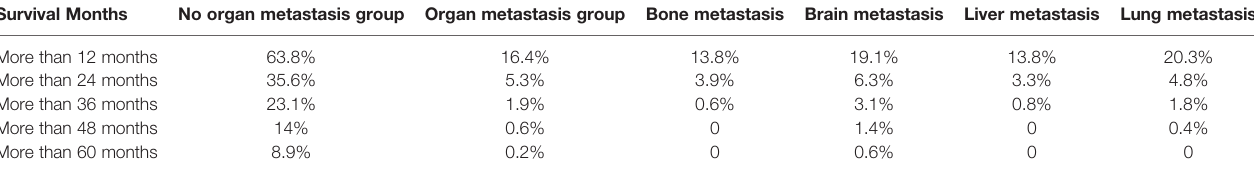
TABLE 5 | Survival time comparison.